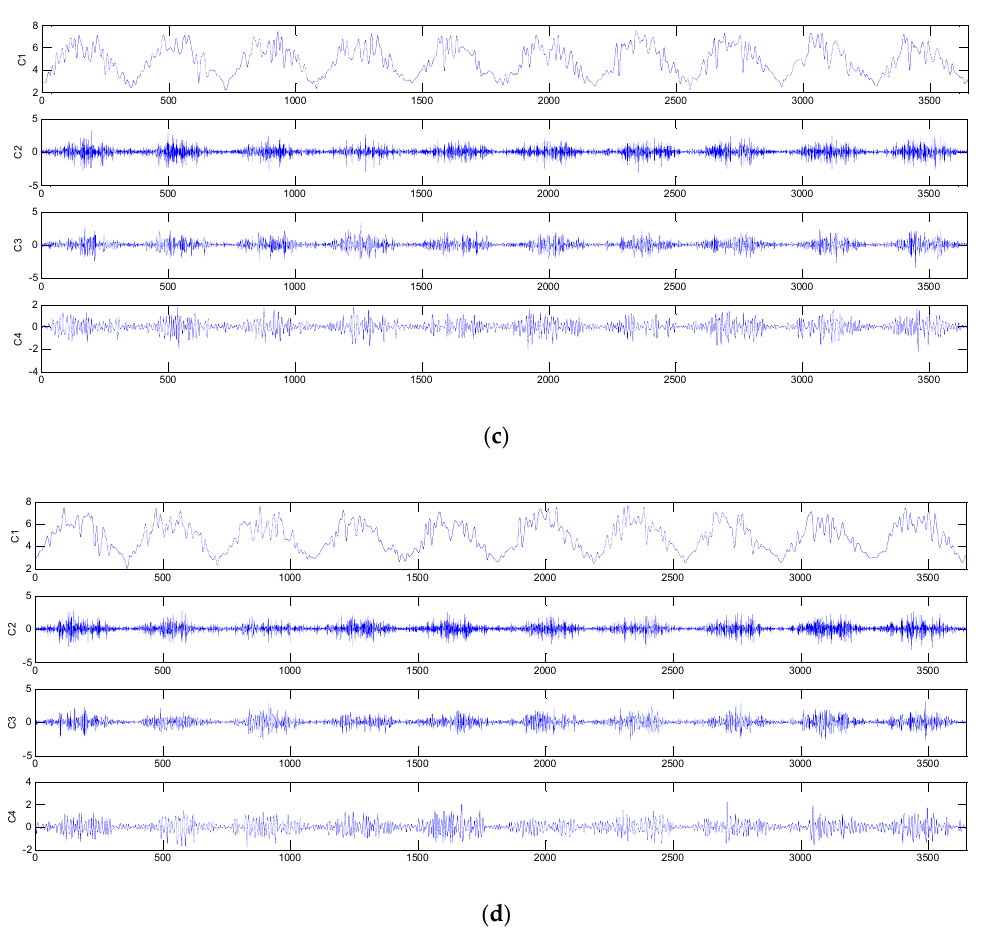
Figure 2. IMFs obtained from EEMD using daily solar radiation data of ( a ) 1984–1993, ( b ) 1985–1994; and sub sequences with different frequencies derived from WA using daily solar radiation data of ( c ) 1984–1993, ( d ) 1985–1994.